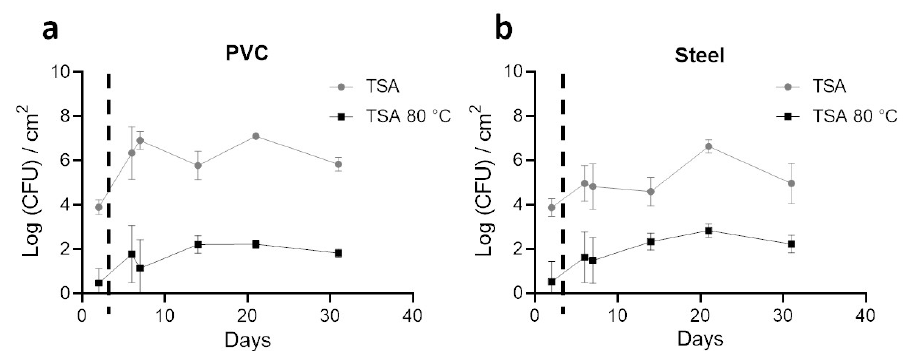
Figure 4. Enumeration profiles (Log CFU/cm 2 ) of the total aerobic bacteria (TSA) and spores (TSA, 80ºC, 10min) on steel and PVC coupons during the trial. Biofilms on coupons were removed mechanically by pipetting and by a round trip with saline solution. After successive dilutions, bacteria inside samples were enumerated on TSA (grey lines) and on TSA after a 10 min at 80 °C treatment to select spores (black lines). Results are average ±CI 95% of 2 enumeration profiles for PVC ( a ) and Steel ( b ) coupons. The dotted line indicates the animal’s entry into the building.